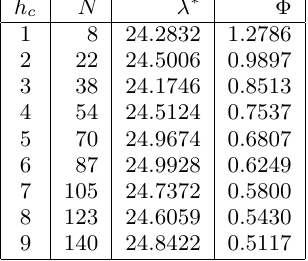
to the high priority traffic streams 2 and 4 is much slower than that experienced by the lower priority streams 1 and